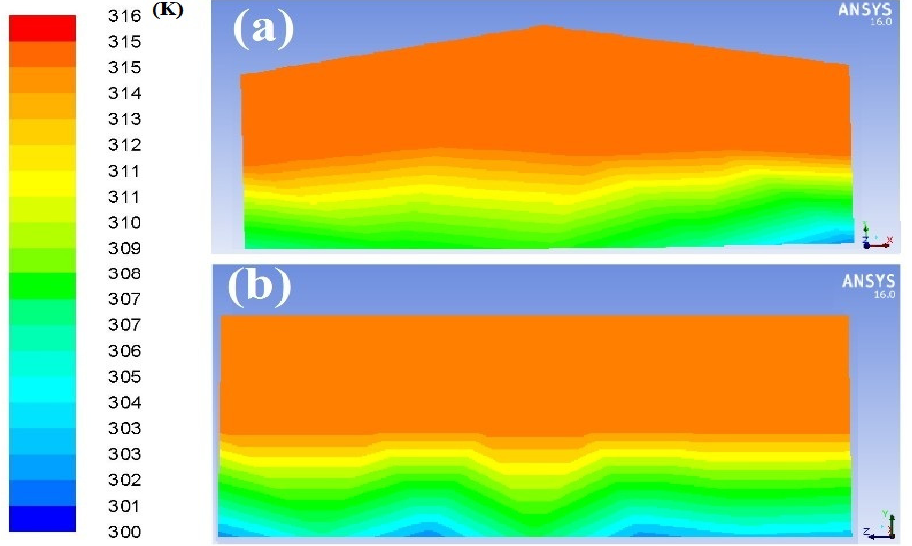
Figure 9. Temperature distribution (K) in the center of the greenhouse at noon during 15 February 2017: frontal ( a ) and longitudinal ( b ) view.